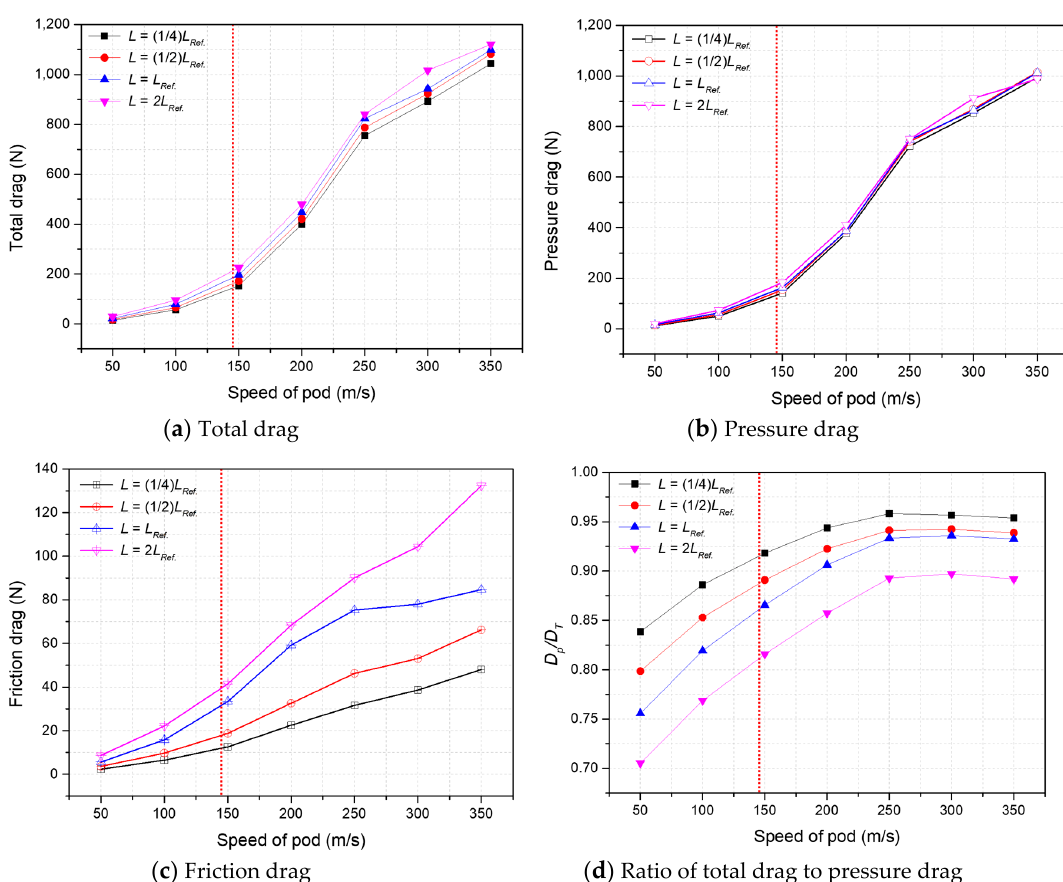
Figure 6. Effects of the pod length on drag.